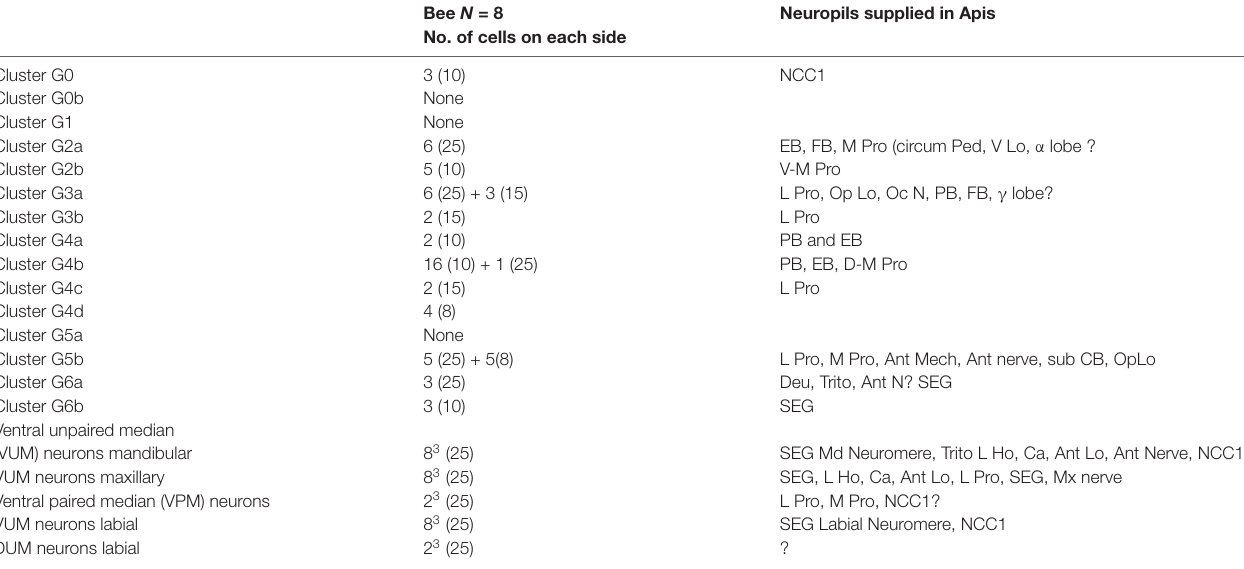
TABLE 1 | The number of tyramine-like immunoreactive neurons in clusters of cells in the brain and subesophageal ganglion of Apis mellifera 1,2 . Bee N = 8 Neuropils supplied in Apis No. of cells on each